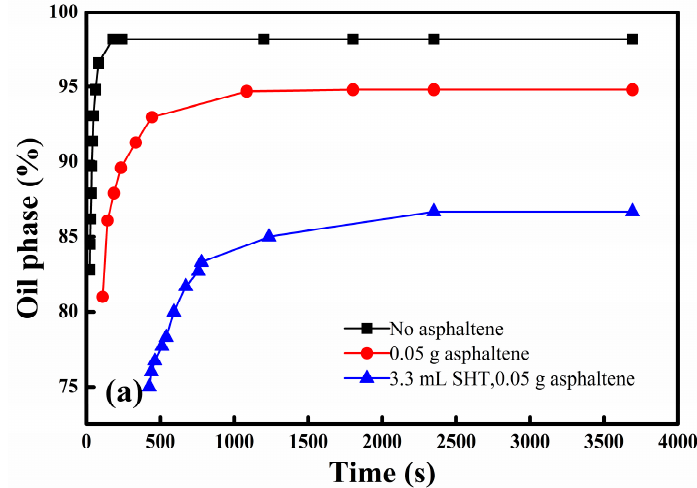
Figure 5. The variation of solution pH as a function of reaction time at different temperatures, Et 3 N/H 2 O volume ratios, and CO 2 injecting